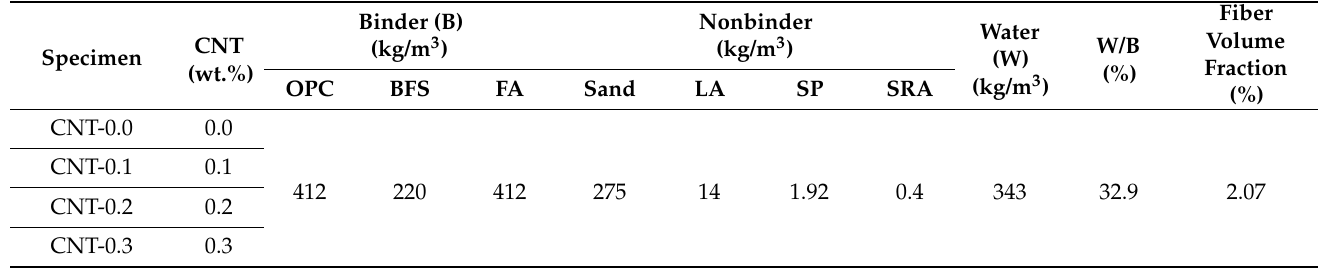
Table 2. Mix proportions of PVA cementitious composites with CNTs.